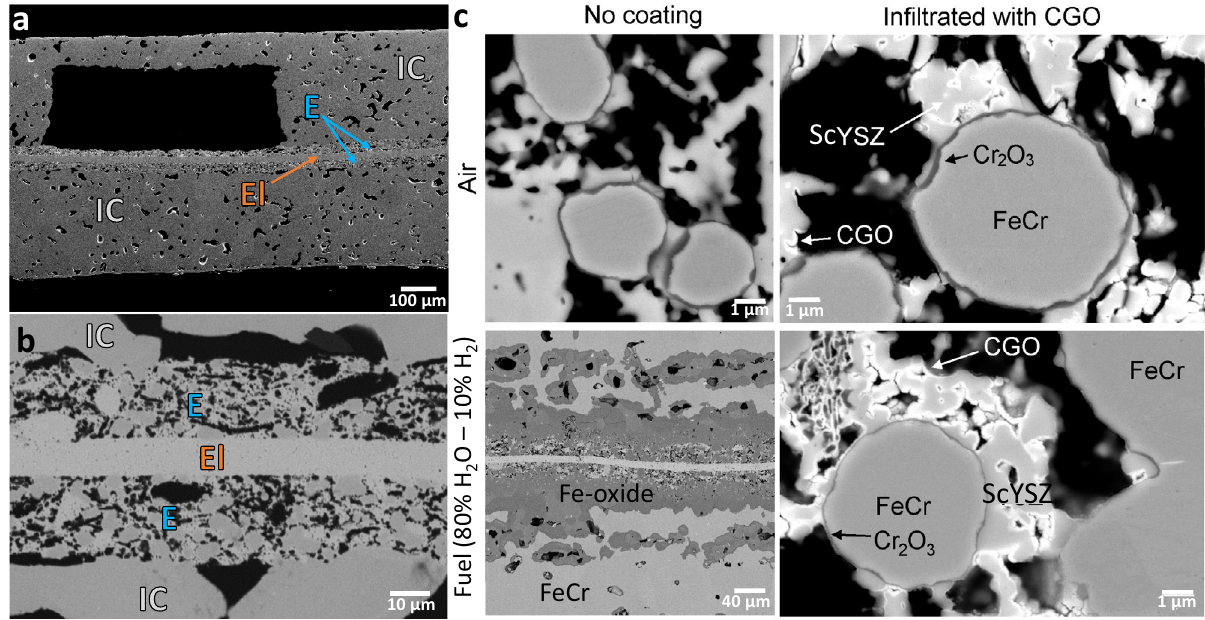
Fig. 3 Microstructural analyses of the monolith. a Cross-sectional SEM image showing the SRU monolith with a gas channel enlarged. The annotations E, El, and IC correspond to electrode, electrolyte, and interconnect, respectively. b High-magni fi cation cross-sectional SEM images of the cell layers. c Cross- sectional SEM images of the SRU monoliths after oxidation in air or 80% H 2 O – 20% H 2 for 100 h at 650 °C. Note the scale